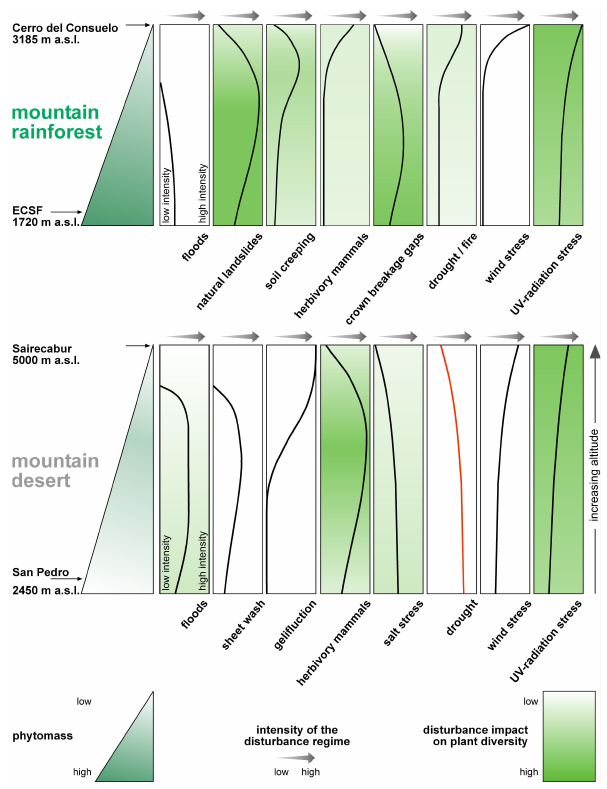
Fig. 8. Relative intensity (i.e. frequency and extensiveness, see ar- row in the legend) of natural disturbances or stress (lines) and im- portance of perturbative effects for vascular plant diversity (colours) within the two study areas representing the perhumid part (top, i.e. the San Francisco Valley above the Scientific Station ECSF) and the arid Andes (below, i.e. the western escarpment of the high Atacama below Volc´an